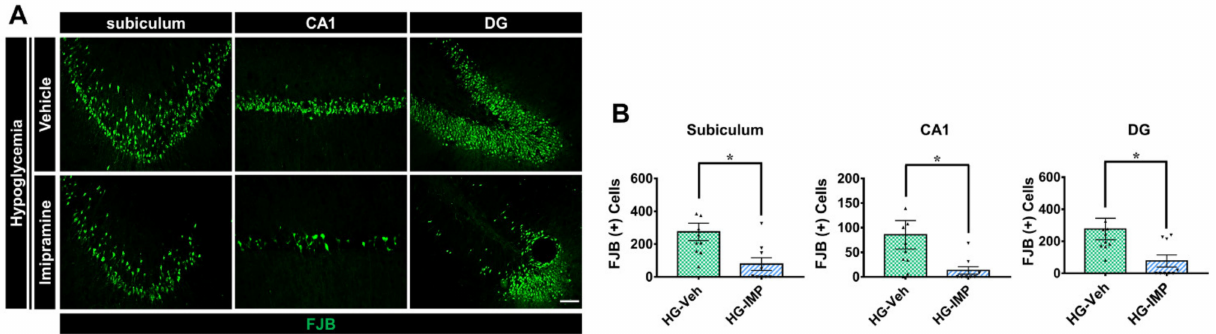
Figure 2. Effects of imipramine (IMP) on hypoglycemia-induced hippocampal neuronal death. Hypoglycemia resulted in hippocampal neuronal death in the subiculum (subi), CA1, and DG regions. ( A ) Fluoro-Jade B (FJB)-positive neuronal cells, degenerating cells, were observed in the subi, CA1, and DG regions after hypoglycemia. Scale bar = 50 µ m. ( B ) The number of FJB (+) cells was greatly lower in the imipramine-treated group than in the vehicle group after insult. Data are the mean ± SEM; n = 9–10 from each hypoglycemia group. Individual data points ( (cid:78) = HG-Veh, (cid:72) = HG-IMP). * Significantly different from the vehicle-treated group at p <